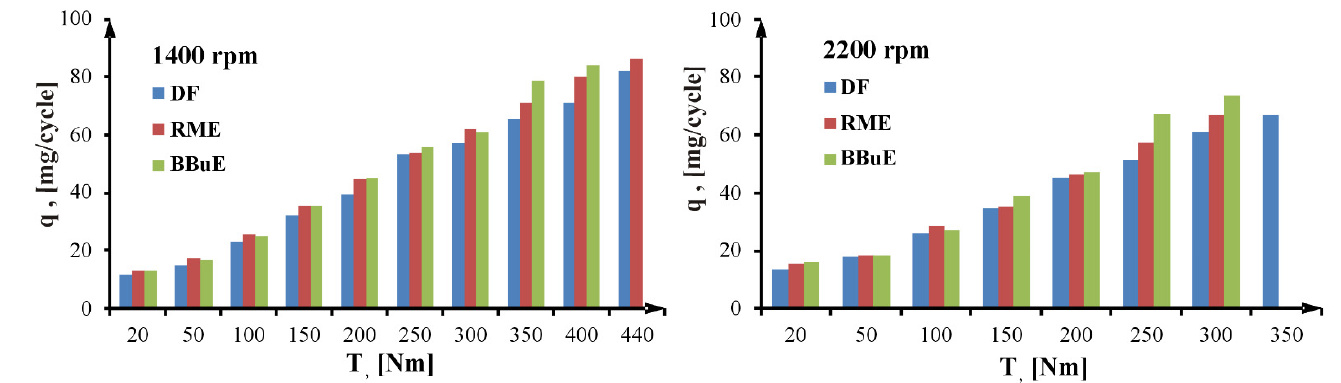
Figure 3. Fuel dose per cycle, with the engine running according to the load characteristics for 1400 and 2200 rpm. 1400 and 2200